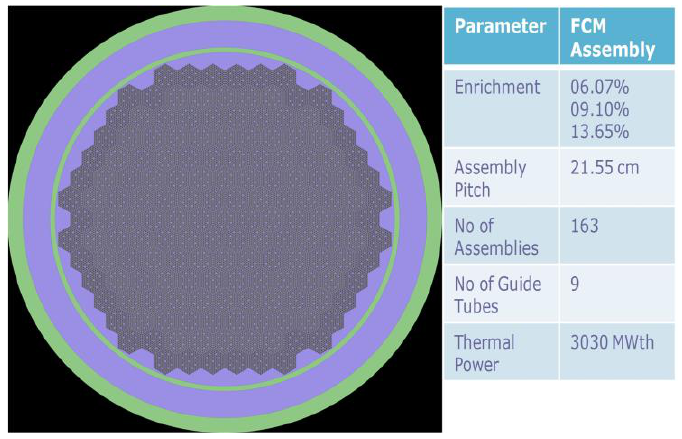
Figure 9. Full Core geometry with